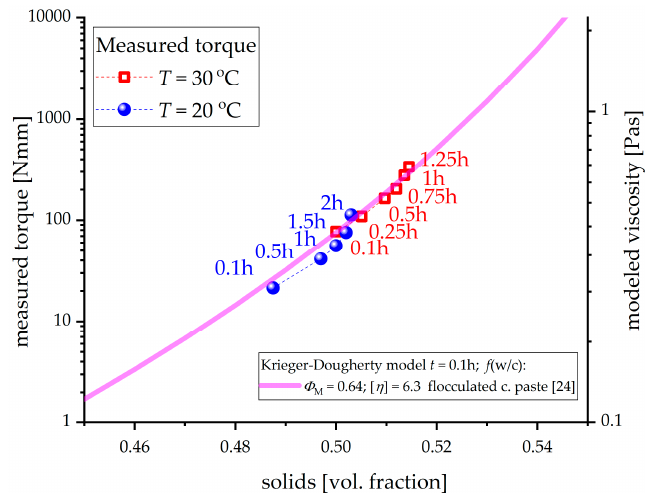
Figure 6. Correlation between measured torque and solids content. To get good agreement between measured and modeled results, only the torque values are scaled to modeled viscosity while keeping the Krieger-Dougherty parameters fixed to the literature values calibrated for the flocculated cement paste (as a function of w/c ratio [24]).